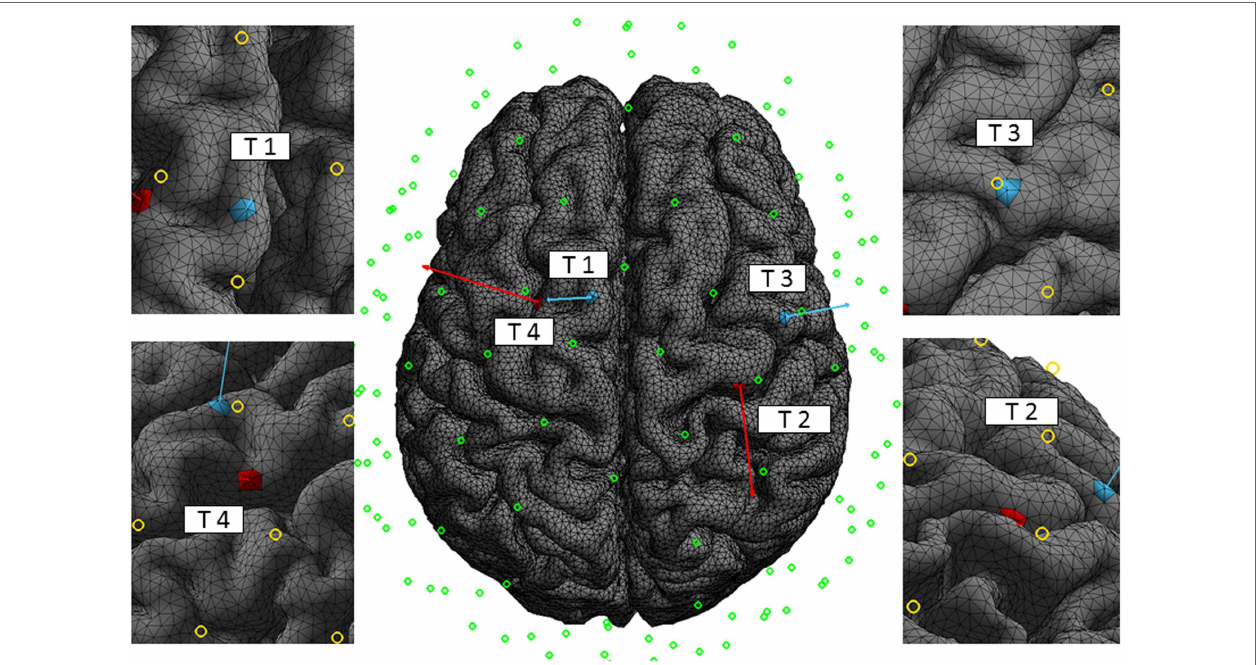
FIGURE 5 | Targets. The four trial targets on the cortex, T1, T2, T3, and T4, are shown with the corresponding normal vectors of 5cm length for better visualization. Normal vectors of targets T1 and T3 are mostly perpendicular and normal vectors of targets T2 and T4 are mostly tangential to the scalp surface. The circles indicate the central position of the electrodes of the 128 EGI sensor net. The normal vector projections to the scalp for T2 and T3 are close to a specific electrode in the 128 montage, while the similar projections for T1 and T4 are in between. The left and right figures are close-up views of the targets with their corresponding normal vectors.